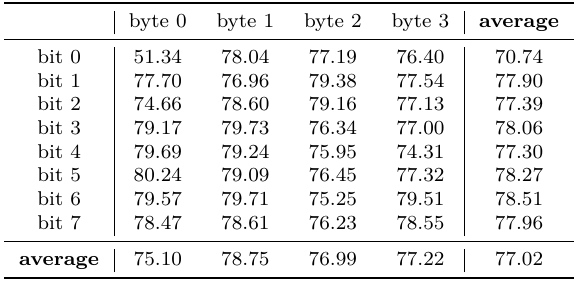
Table 7: SOST of the first 4 message bytes for poly_A2A()